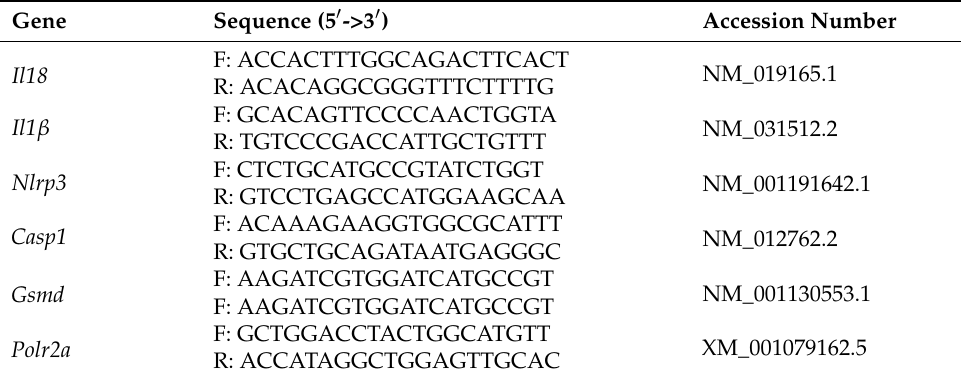
Table 1. List of genes and nucleotide sequence of primers for